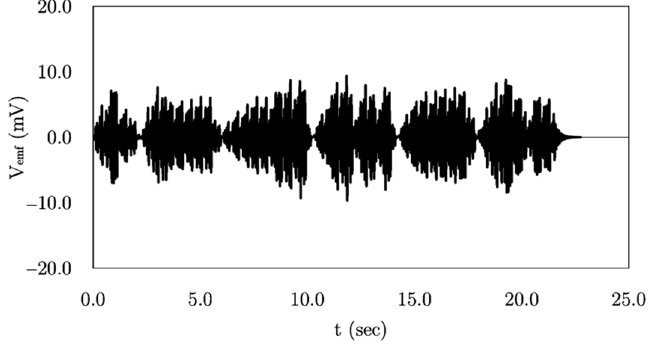
Figure 14. Voltage output from the SDOF model subjected to base excitations with the frequency from f b = 2.3 Hz.